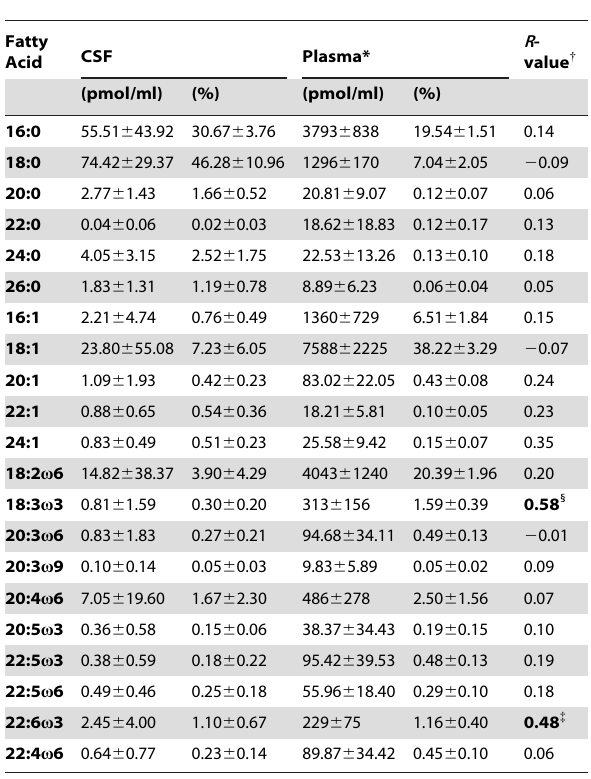
Table 1. Fatty acid concentrations in CSF and